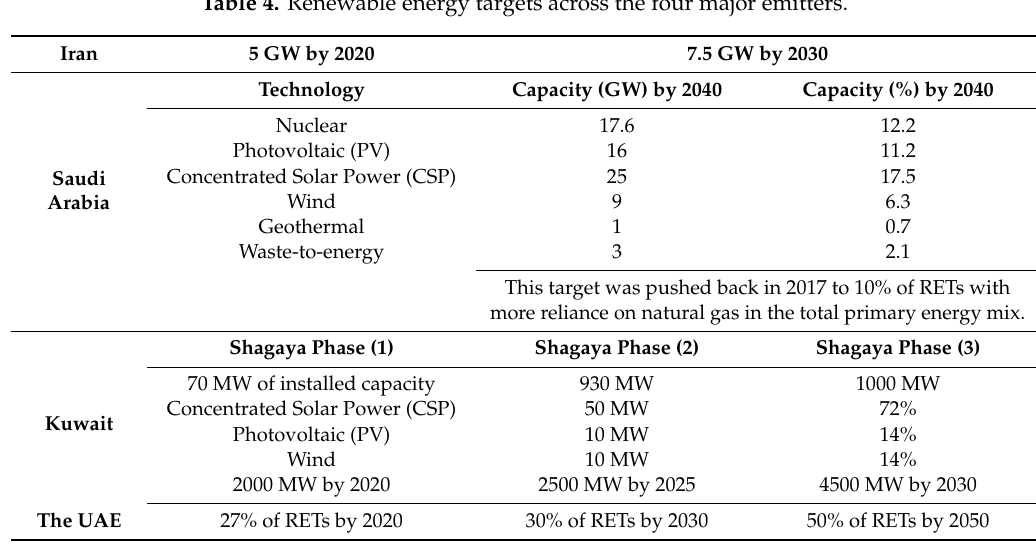
Table 4. Renewable energy targets across the four major